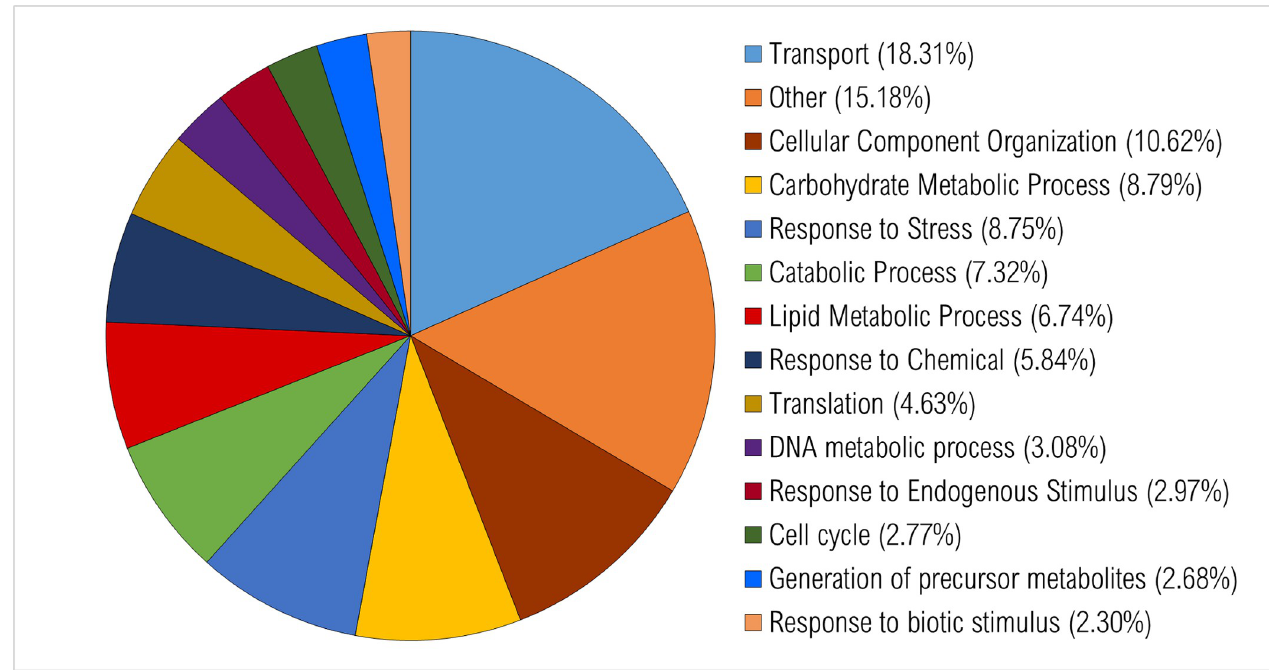
Fig 2. Percentage of transcripts in Populus tremuloides control samples. A total of 9766 transcripts were assigned ontology and grouped by biological processes using BLAST2GO. Categories under 2% were grouped together and classified as “other”.